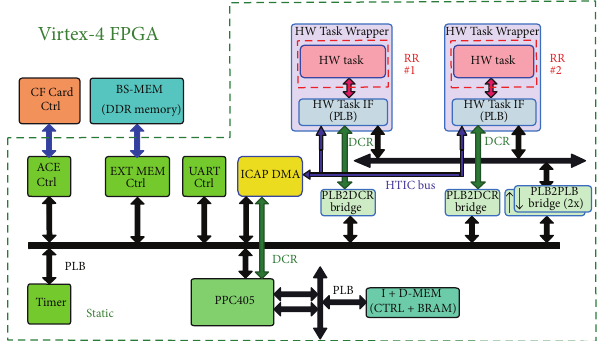
Figure 19: Experimental setup (Rainbow tests).